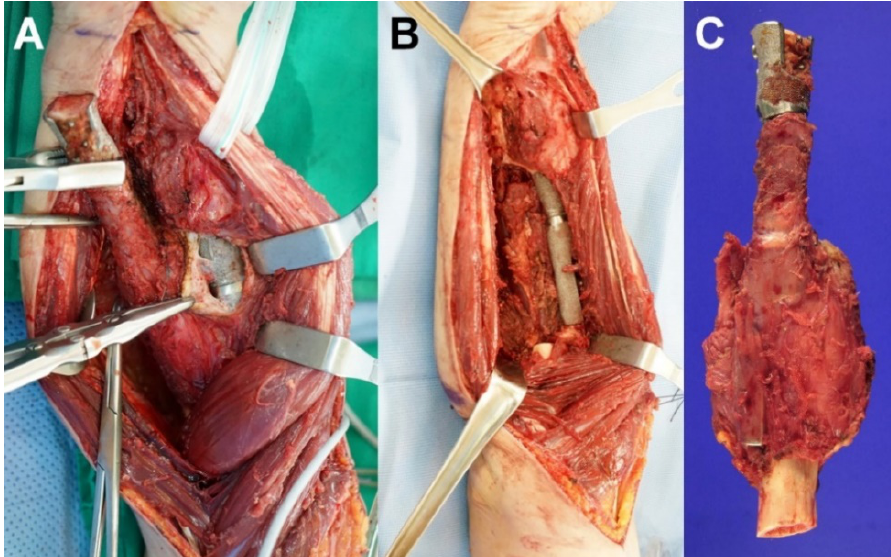
Figure 2. Revisional surgery. Photographs showing ( A ) wide excision of the ulnar implant, ( B ) the soft tissue bed after resection of the recurred tumor, and ( C ) the retrieved ulnar implant with the recurred tumor.